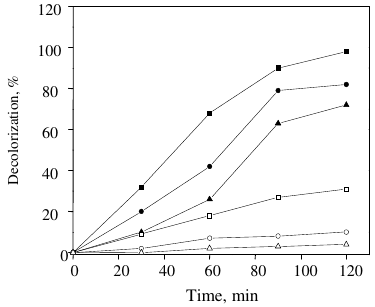
Figure 10 . Effect of pH on the efficiency Figure 9. Effect of pH on the efficiency of decolourization of vat yellow 4 (5 mg/L) of decolourization of Reactive Red 120 under UV light:( ■ ) TiO (5 mg/L) under UV light:( ■ ) TiO /UV.pH 2 /UV pH 7, ( ▲ )TiO /UV pH 10, /UV pH 7, ( ▲ )TiO 4, ( ● )TiO ( ● )TiO 2 2 2 ( □ ) UV pH 4, ( ○ ) UV pH 7, ( ∆ ) UV pH 10. ( □ ) UV pH 4, ( ○ ) UV pH 7, ( ∆ ) UV pH